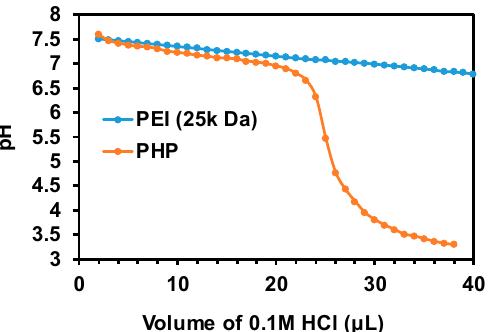
Figure 2. Titration curve of branched polyethylenimine (PEI, Mw = 25 k Da, 2 mg/mL) and PHP (2 mg/mL) by addition of 0.1 M HCl (20 °C).